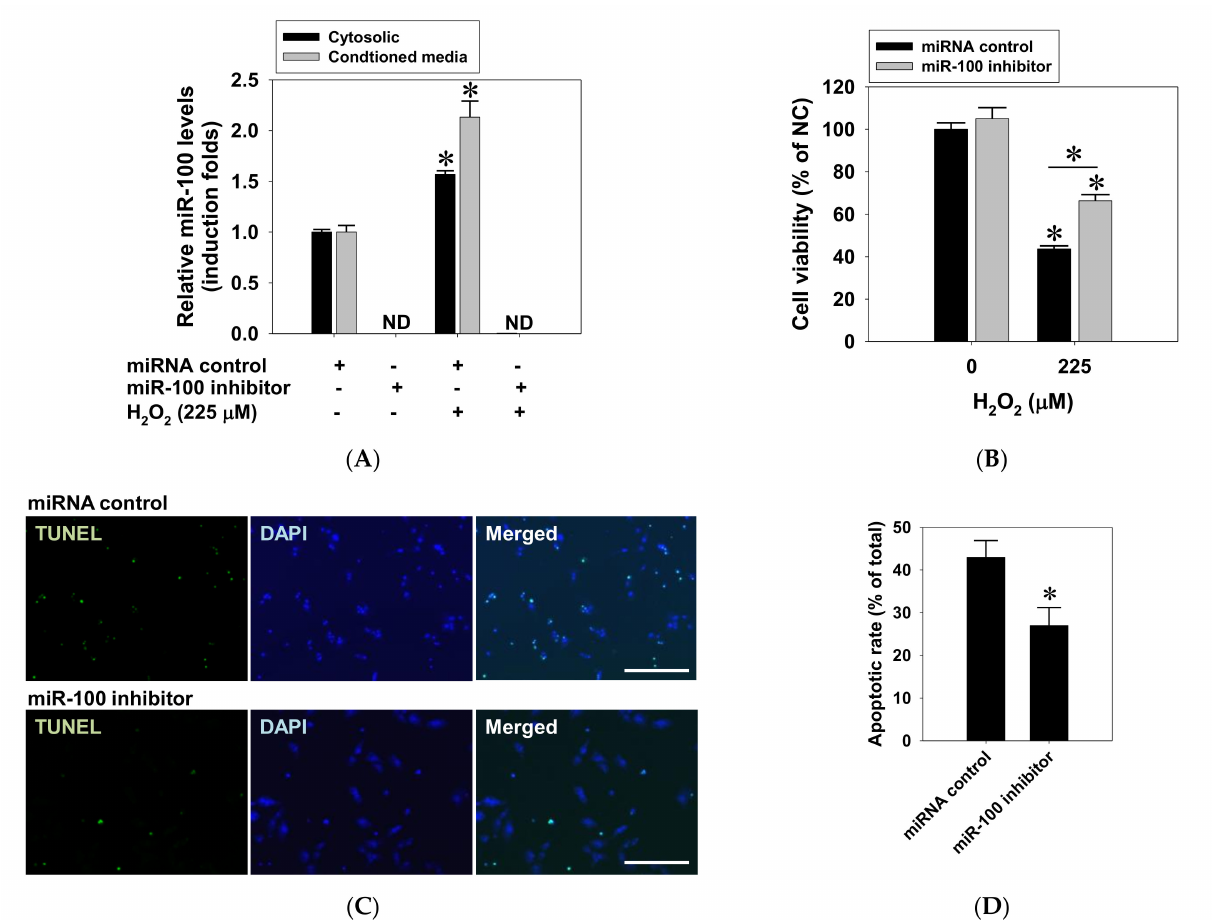
Figure 5. Mitigation of hydrogen peroxide-induced apoptosis of human ARPE-19 cells by miR-100 antagonism. ARPE-19 cells were transfected with either a 200 nM miR-100 antagonist or control oligonucleotides for 24 h followed by H 2 O 2 exposure at 225 µ M for another 24 h. ( A ) Cellular lysates and conditioned media were collected for miRNA isolation and miR-100 detection by RT-qPCR. ND, not detectable. ( B ) Cytotoxicity assay was used to determine the viability of the treated cells. Alternatively, the treated cells were fixed and subjected to fluorescent TUNEL staining ( C ) and subsequent analysis on TUNEL staining positivity ( D ). Data are expressed as mean ± SD from three independent experiments. * p < 0.05 vs. control or between indicated groups, by ANOVA. Scale bar = 50 µ m. +/ − indicates presence/absence of